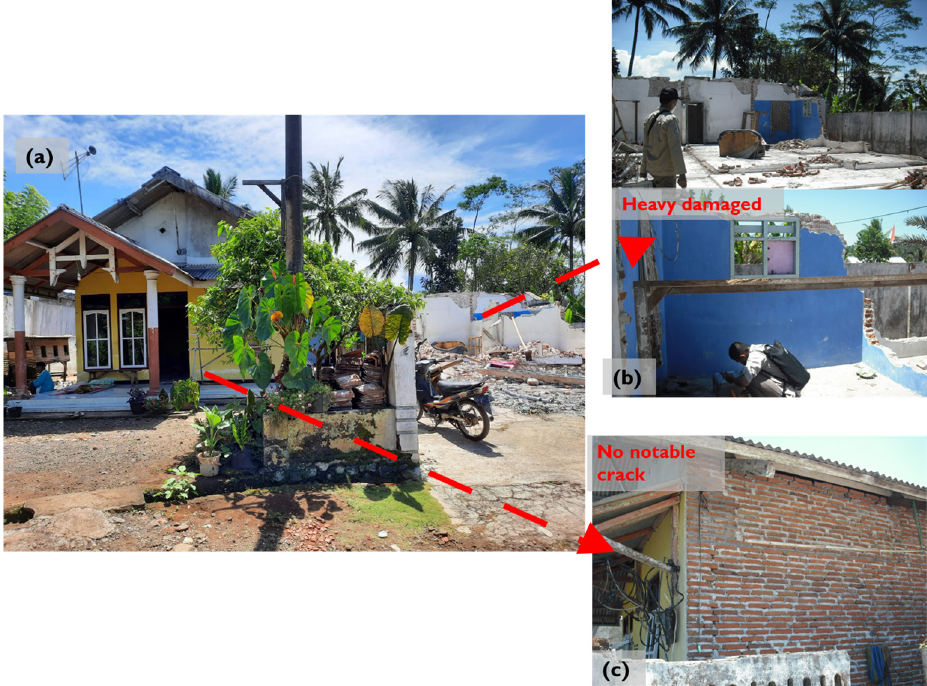
Figure 3. ( a ) Two neighboring UM housing after an earthquake: ( b ) heavy damage on the right house, while ( c ) no remarkable damage on the left house.